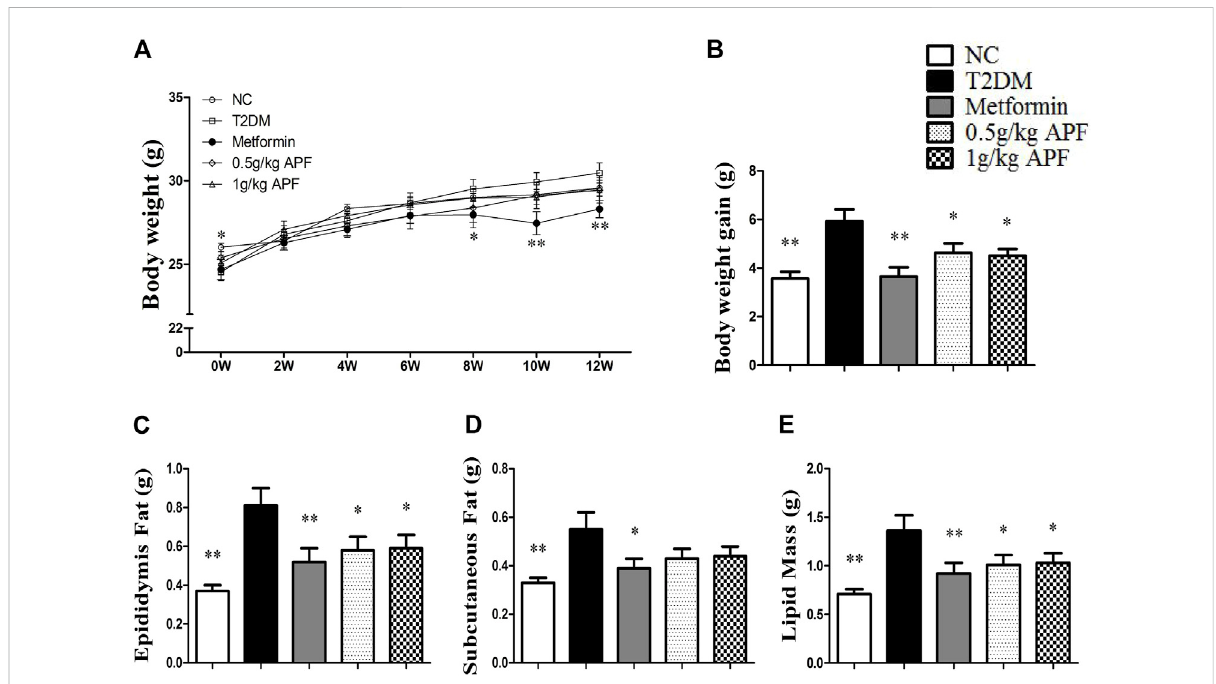
EffectsofAPFonobesityinT2DMmice.Bodyweightchanges (A) ,bodyweightgain (B) ,epidydymalfatmass (C) ,subcutaneousfatmass (D) and total fat mass (E) of normal control (white bars), type 2 diabetes group (black bars), metformin group (gray bars), 0.5 g/kg APF group (spot bars)